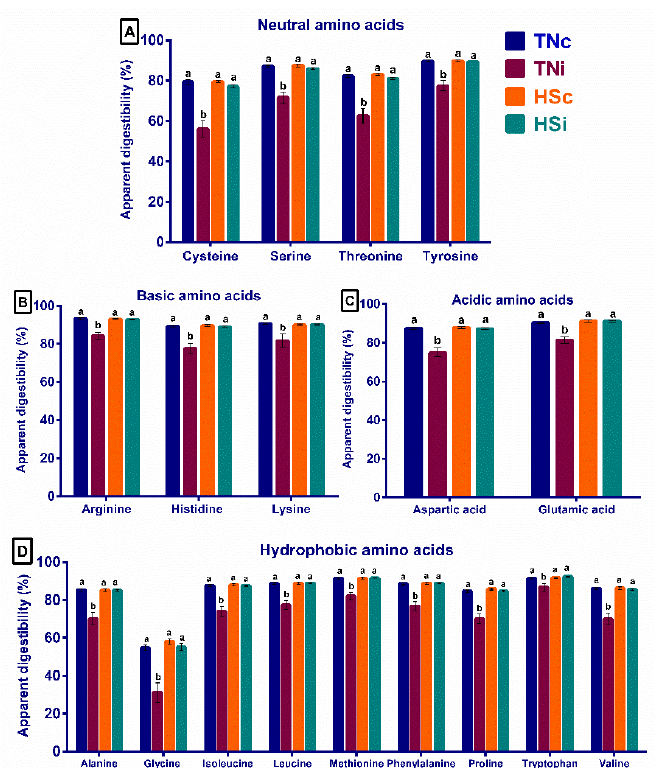
Figure 1. The apparent ileal digestibility of the neutral ( A ), basic ( B ), acidic ( C ), and hydrophobic ( D ) amino acids at 6 dpi of E. maxima infected chickens raised under thermoneutral (TNi) and heat-stress (HSi) conditions, as compared to uninfected control chickens raised under thermoneutral (TNc) or heat-stress (HSc) conditions (N = 6). Significant differences ( p < 0.05) are depicted by different letters. The error bars represent the SEM. The non-proteinogenic amino (hydroxyproline and ornithine) and sulphonic acids (lanthionine and taurine) displayed similar AID pattern, even though the AID of the hy- droxyproline and ornithine were negative (Figure 2A,B). The TNi group showed the least the TNi group had the highest ileal concentration of hydroxyproline and ornithine com- pared with the other treatment groups (Figure 2A,B).